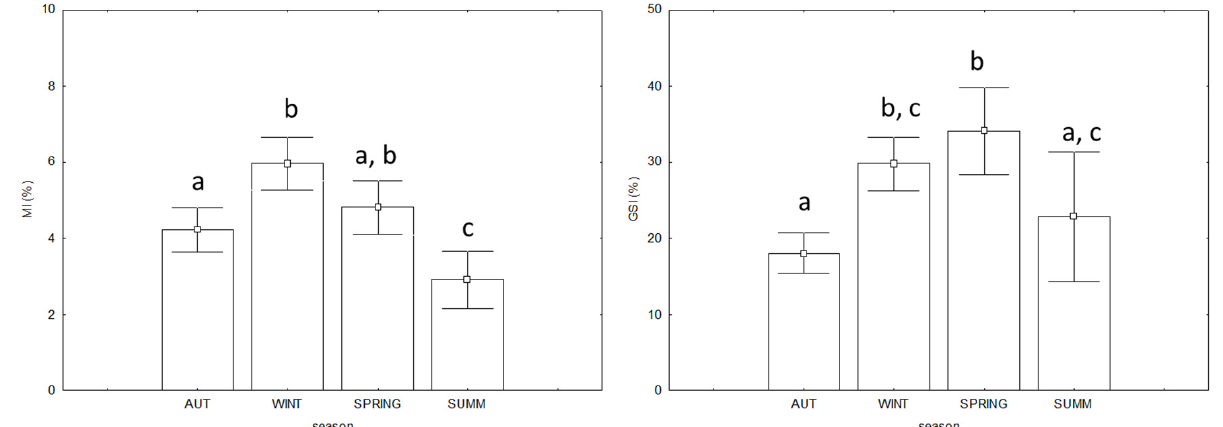
Figure 5. Muscle index (MI, %) and gonadosomatic (GSI, %) of queen scallops ( n = 80) from the tanks, sampled in four seasons: Autumn (AUT), Winter (WINT), Spring (SPRING) and Summer (SUMM). The means labeled by different letters are significantly different (Tukey’s HSD test, p < 0.05). Table 2. Results of the scallop biochemical content analysis with Kruskal–Wallis H test. Statistically significant differences are represented in bold. Significant Kruskal–Wallis H test was followed by a Mann–Whitney post hoc test and when relevant p values are given in the text.